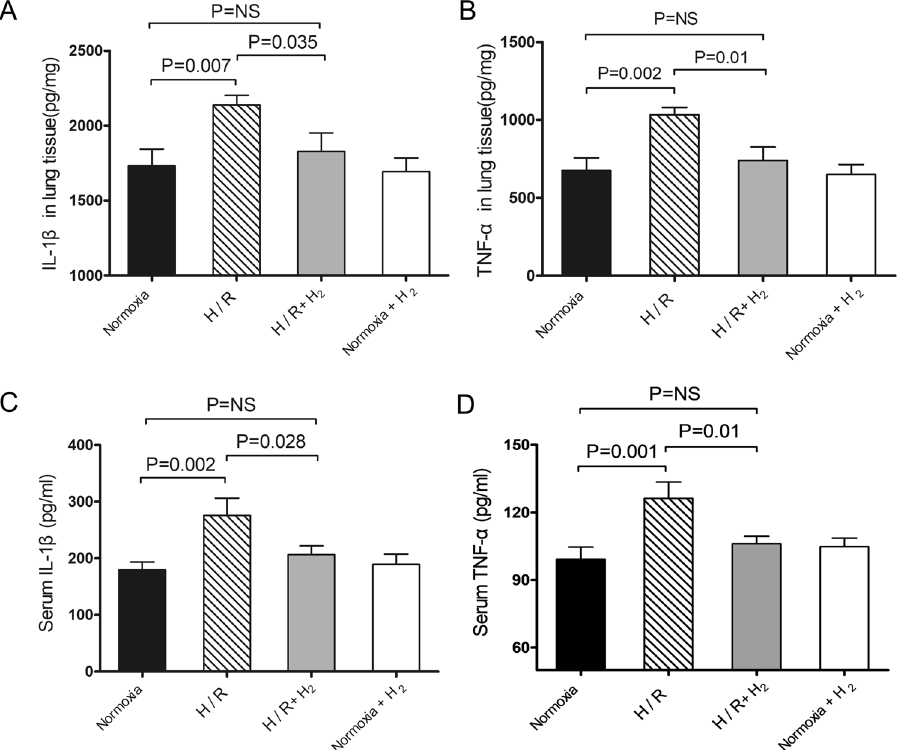
Figure 4. Down-regulation of pulmonary and systemic inflammatory responses by hydrogen. Animals were treated as described in Fig. 1 (n = 10 in each group). The right lung was harvested and homogenized at the end of experiments. After centrifugation, supernatants were harvested and assayed for IL-1 β ( A ) and TNF- α ( B ) using commercial ELISA kits. Blood samples were also extracted and centrifuged for assaying IL-1 β ( C ) and TNF- α ( D ) in serum. Data shown are mean ± SEM. ns, not